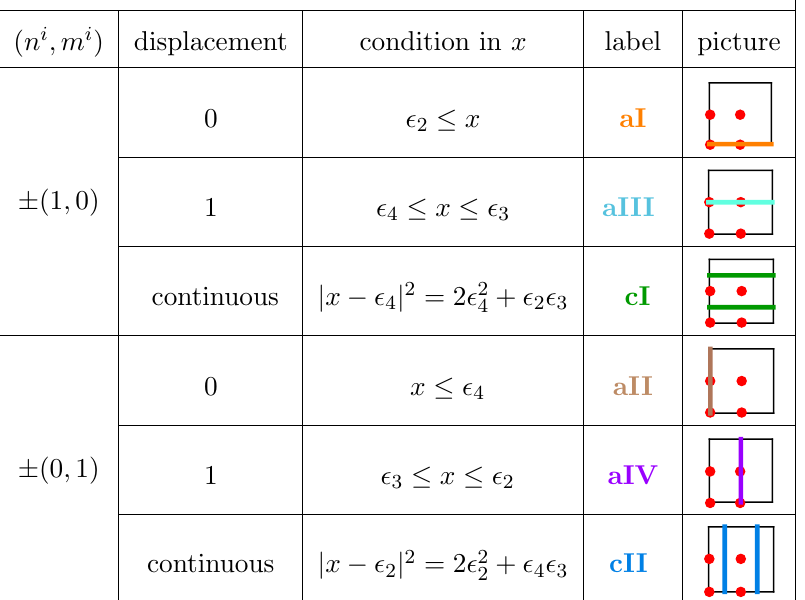
Table 5 . Overview of Lag lines on an elliptic curve corresponding to a square untilted two-torus. The (cid:12)rst column lists the torus wrapping numbers ( n i ; m i ) describing how the one-cycles wrap on the two-torus lattice, while the second column indicates a potential displacement along one of the basis one-cycles (we distinguish between no displacement, a displacement over one-half of a basis one-cycle or a continuous displacement in between the latter two options). The third column presents the equation for the Lag line in the homogenous coordinate x (considering the v = 1 patch) in line with (cid:12)gure 2 (a). The last column gives a graphical representation of the Lag one-cycle on the two-torus